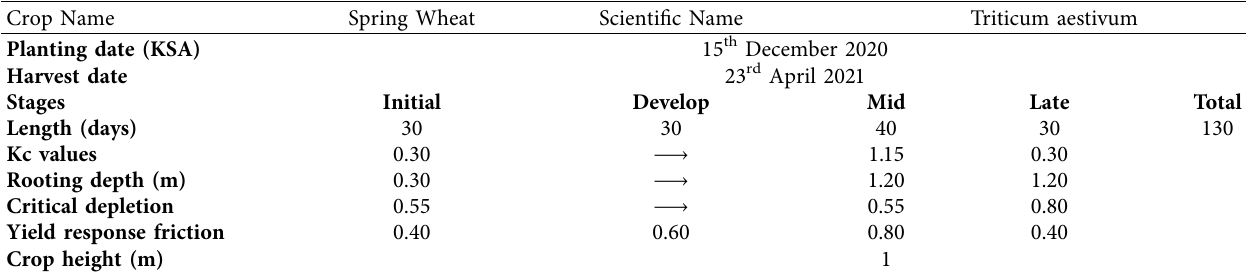
Table 8: Wheat crop data at various stages.